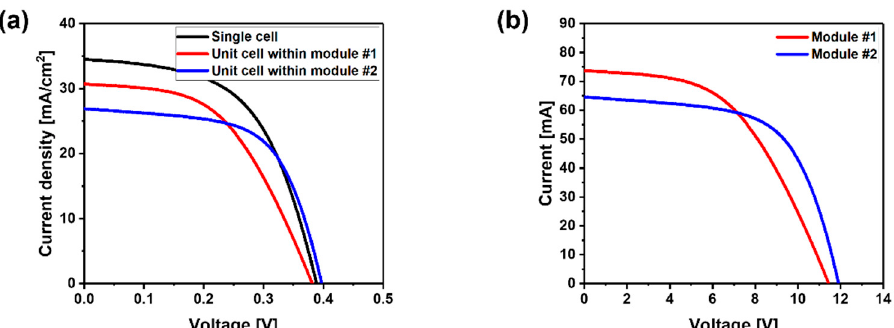
Figure 5. EBIC mapping image of MOCVD-prepared buffer-less CIS solar cell.